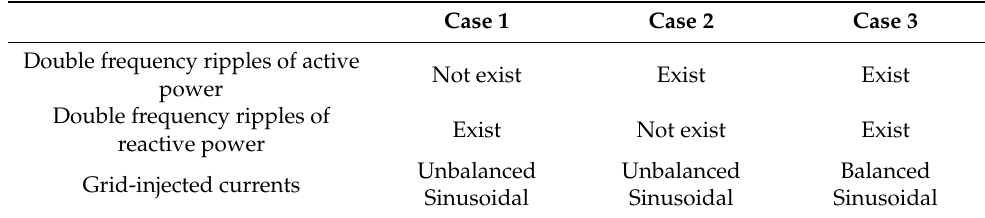
Table 2. A comparison with three di ff erent control targets Case 1 Case 2 Case